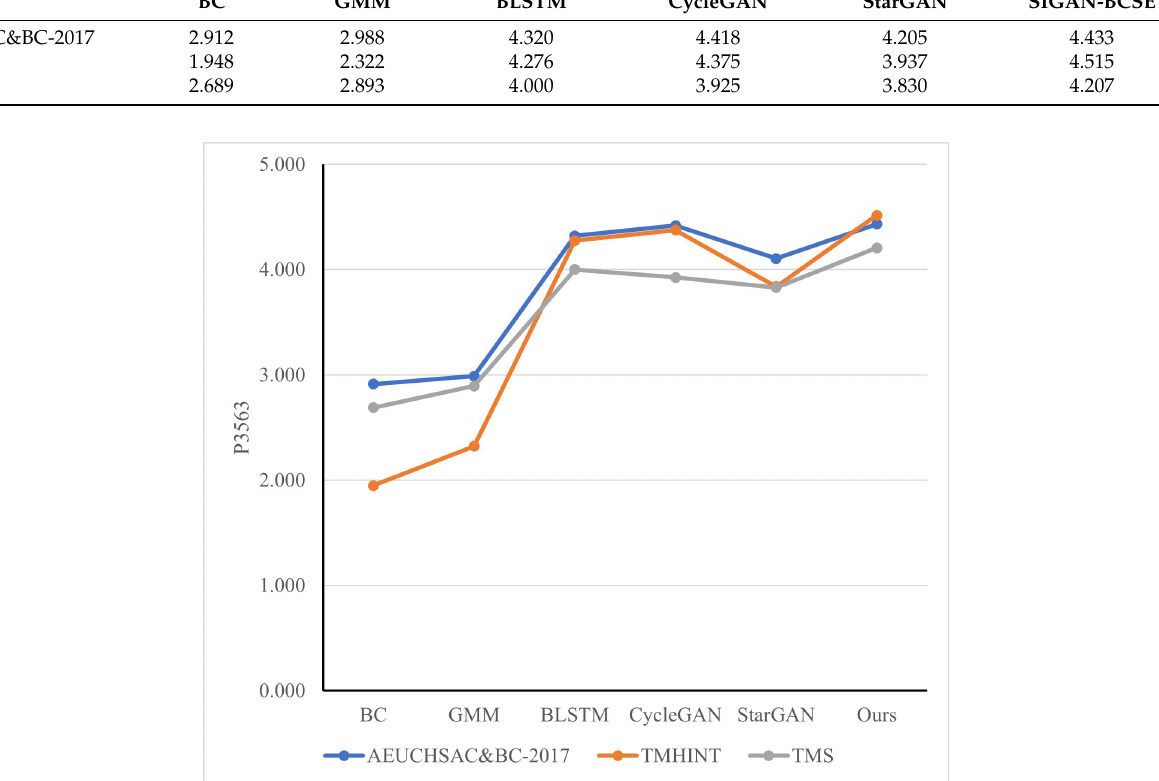
Figure 9. P.563 scores of enhanced BC speech obtained by different methods.